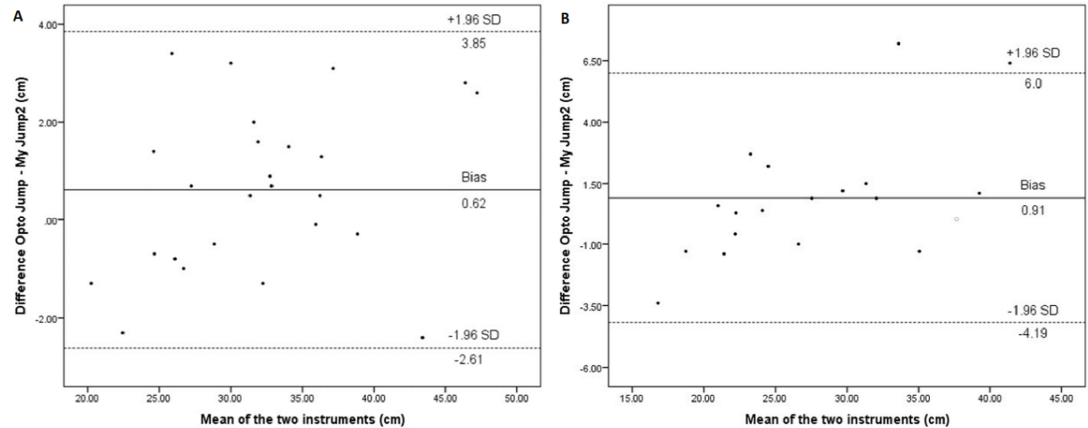
Figure 2. Level of agreement (Bland–Altman) with 95% limits of agreement (dashed lines) and the mean difference (solid line) between My Jump 2 and the Optojump for SJ in ( A ) male and ( B ) female participants.